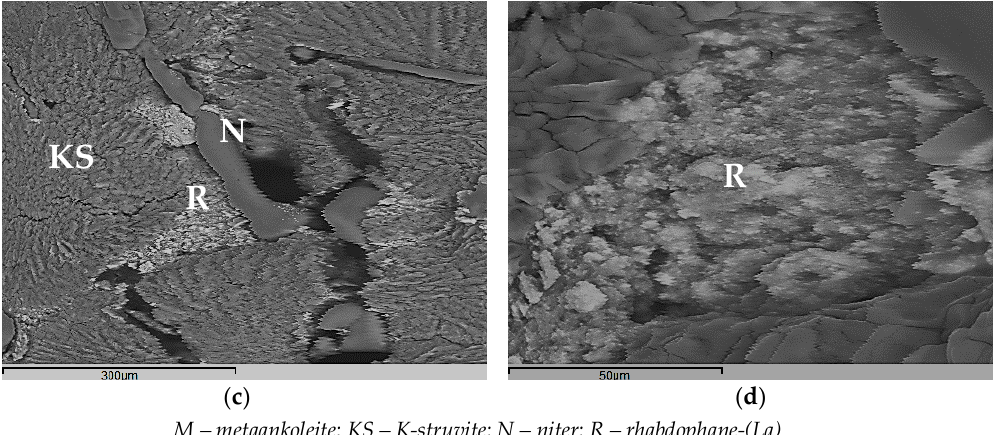
Figure 2. Scanning electron microscopy (SEM) images of the compounds #1 ( a , b ) and #2 ( c , d ), containing 6.2 wt % and 6.7 wt % uranium and lanthanum, respectively.